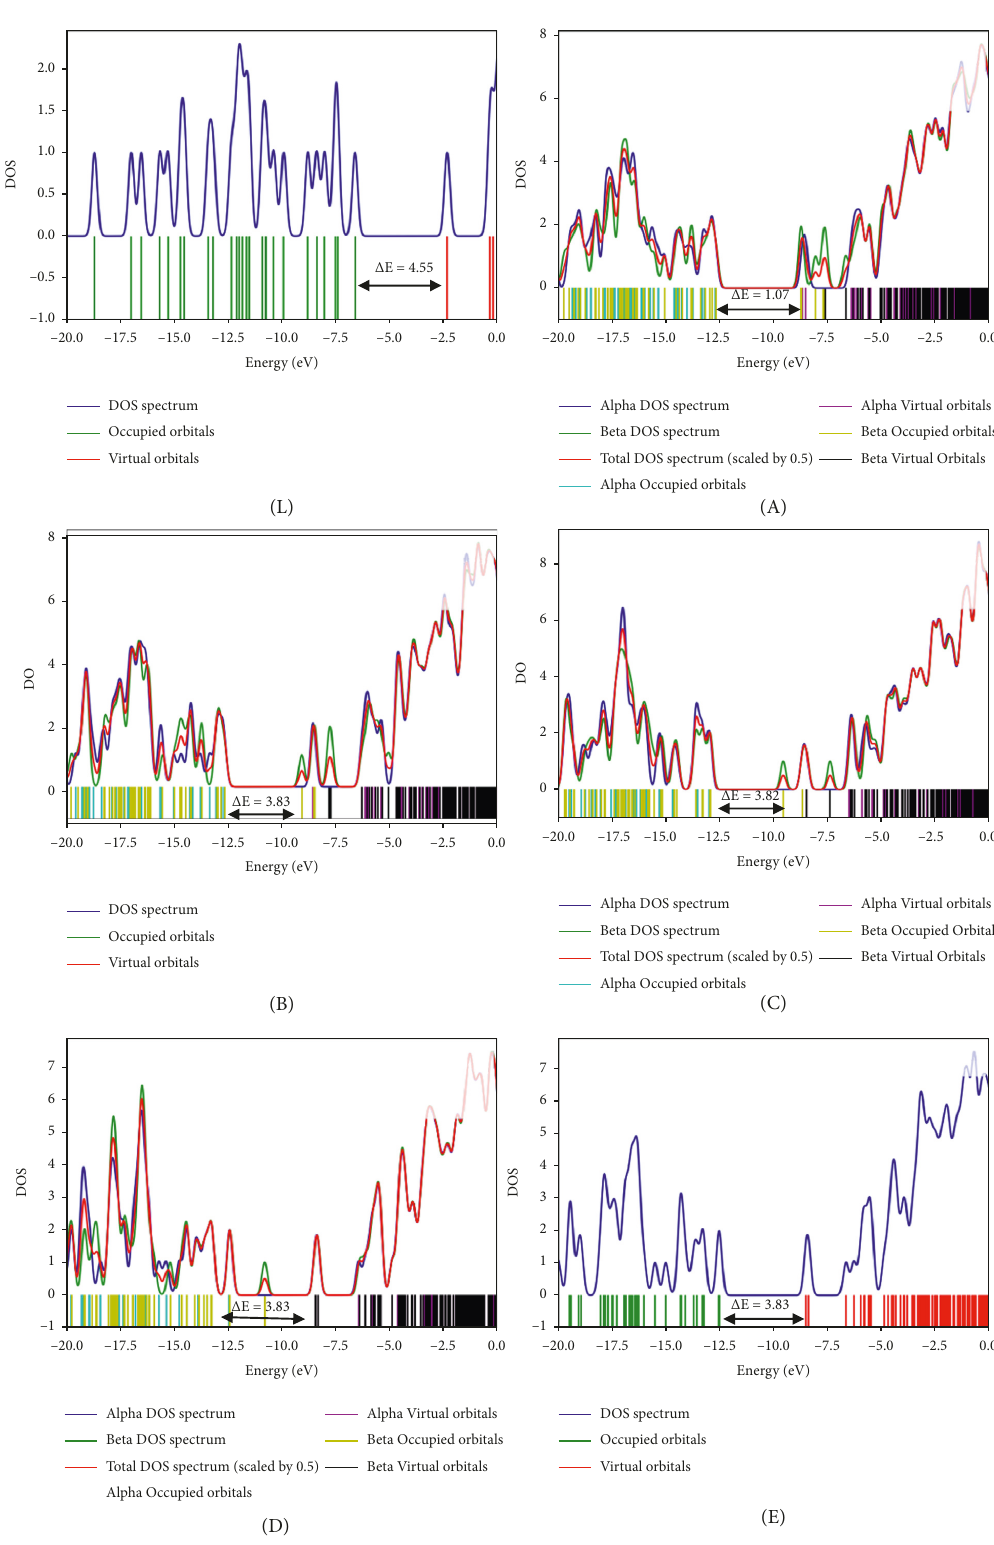
Figure 3: Density of state (DOS) plots of investigated chemical